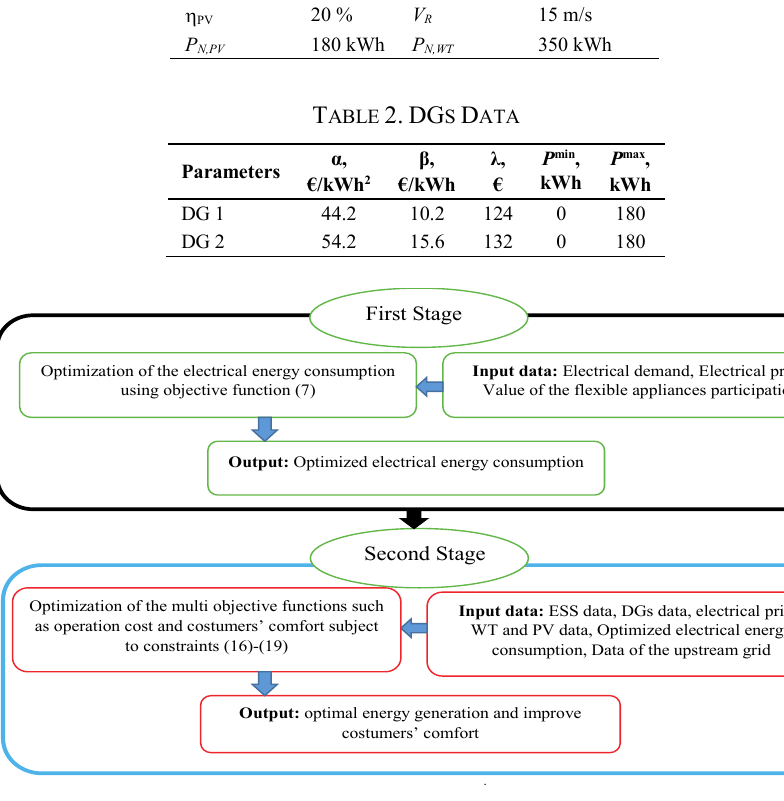
Fig. 2. Optimization